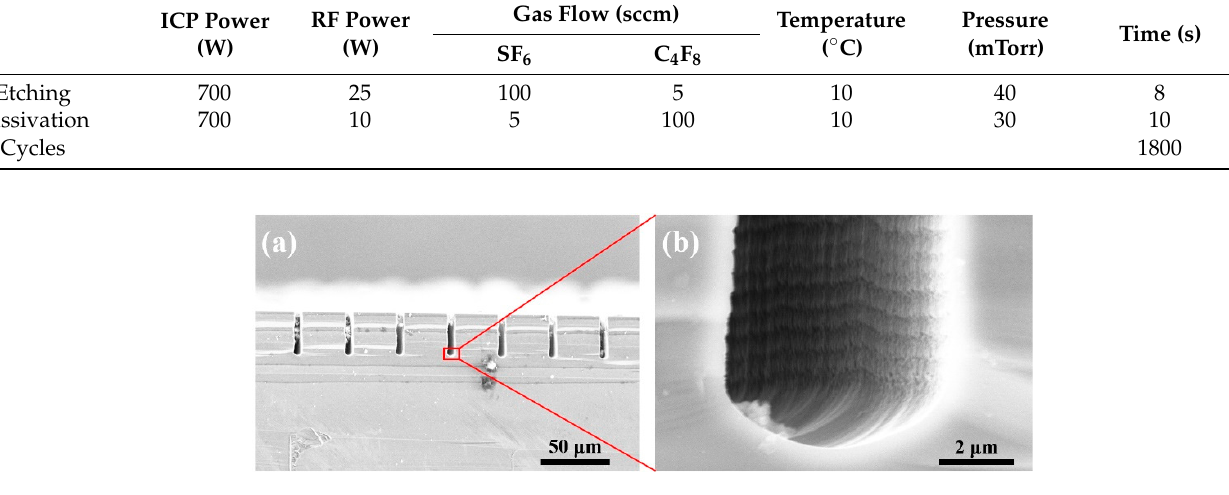
Figure 4. SEM images of ( a ) trenches and ( b ) sidewall of micro trenches by Bosch process.